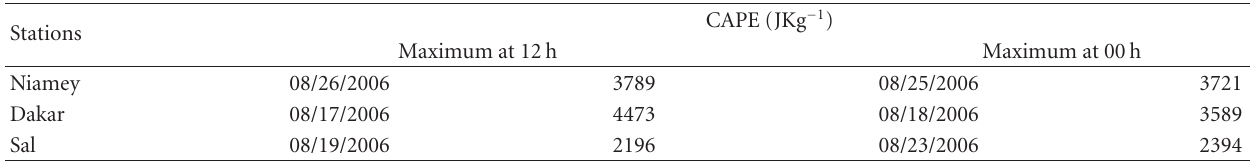
Figure 1: Data availability for the di ff erent categories of sites for the months of June (a), July (b), August (c), September (d) of 2006. Table 1: CAPE maximum values for the selected case